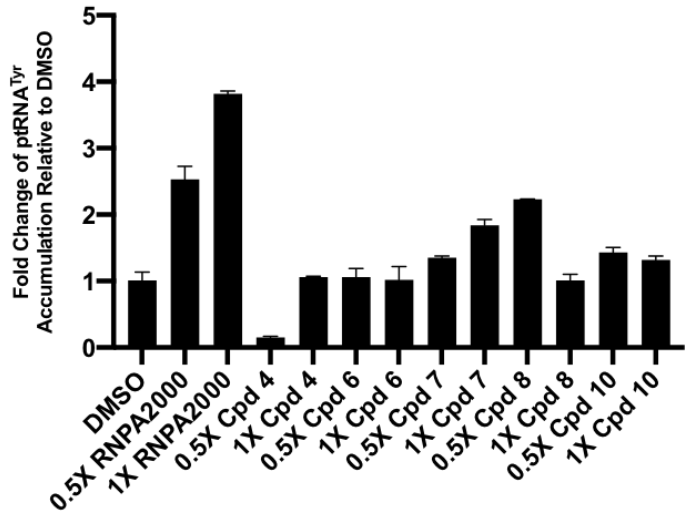
Figure 7. ptRNA accumulation cellular assay. Quantitative RT-PCR measures of ptRNA Tyr accu- mulation in S. aureus UAMS-1 cells treated with DMSO, analogues or RNPA2000 (positive control). Cells were treated with 0.5× or 1× MIC for 1 h. Each compound was evaluated twice, and the values were averaged.